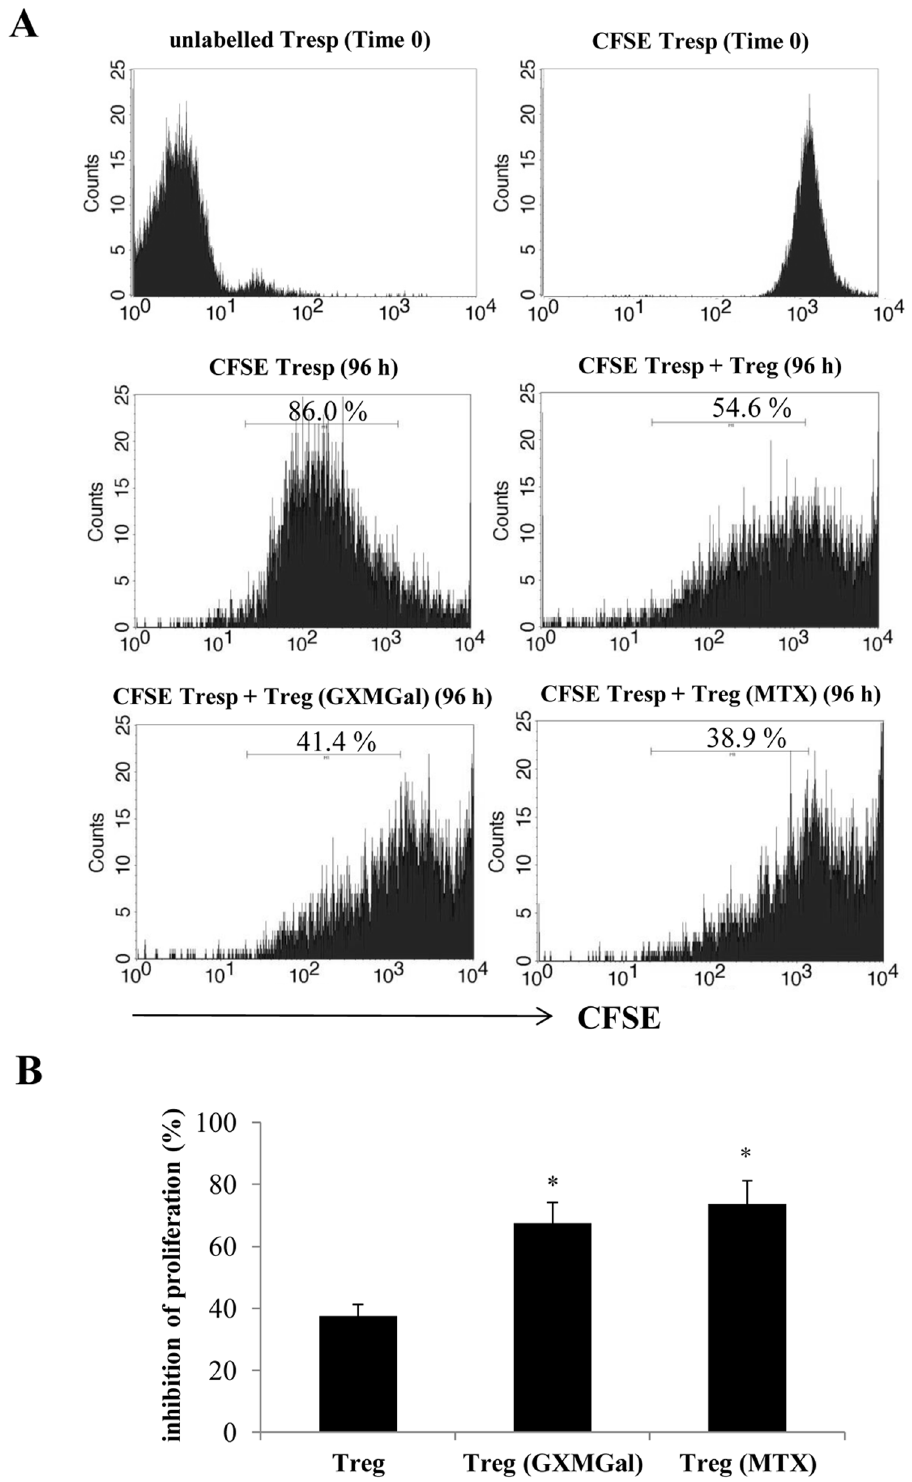
Figure 4. GXMGal effect on Treg cell suppressive activity. Activated RA purified CD4 + T cells (1 6 10 6 /ml) were stained with CFSE (1 m M) and then co-cultured for 96 h in the presence or absence of magnetically purified autologous RA Treg cells (Tresp/Treg: 16/1) that have been pre-treated for 18 h in the presence or absence of GXMGal (10 m g/ml) or MTX (10 ng/ml). After 96 h the suppressive activity of Treg cells was evaluated by measuring the percentage of inhibition of proliferation of CD4 + responder T cells (Tresp). Representative CFSE histograms show the distribution of proliferating CFSE-labelled Tresp according to the intensity of the CFSE label from the start of the experiment (Time 0) until 96 h. Given that the initial cell labelling is fairly homogeneous, each CFSE peak represents a cohort of cells that proceed synchronously through the division rounds. The areas within each histograms delimitated by the marker represent the percentage of divided CFSE-labeled cells ( A ). Mean 6 SEM of percentage of proliferation inhibition is shown as bar graph ( B ). *, p , 0.05 (triplicate samples of 10 different RA; treated vs untreated cells). doi:10.1371/journal.pone.0111163.g004 PLOS ONE |